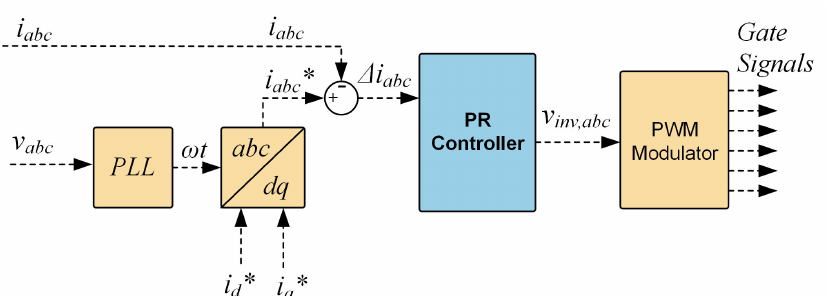
Figure 3. Schematic diagram of a PR-based current controller; PR: proportional-resonant; PWM: pulse width modulation; “*” represents the reference values of the